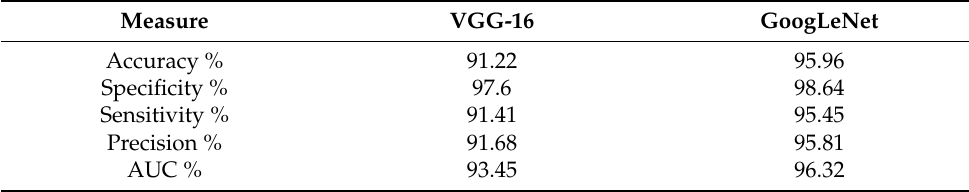
Table 2. Results of the CNN models for cervical cancer data set diagnosis.